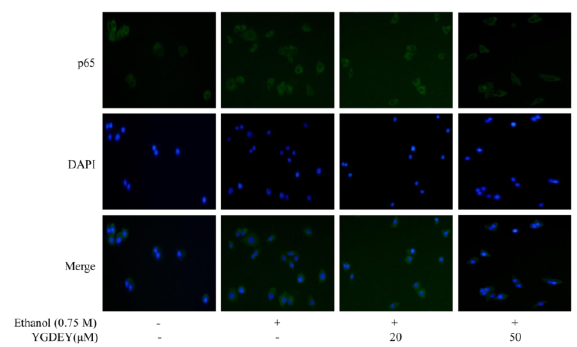
Figure 6. Effect of YGDEY on the cellular localization of p65 in HepG2 cells. Cells were treated with